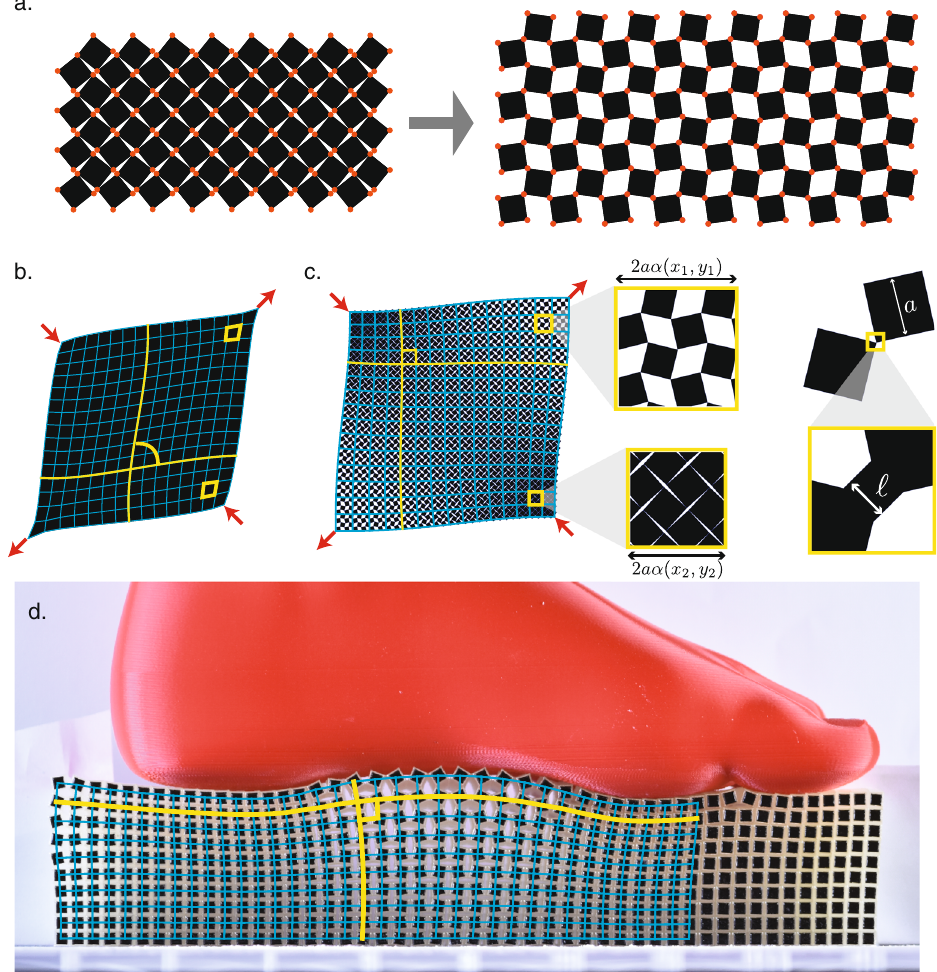
Fig. 1 Dilational mechanism and conformal deformations. a In the ideal rotating square mechanism, a structure of rigid squares (black) connected by frictionless hinges (red), may be dilated and contracted at zero energy cost when the squares are rotated opposite to their neighbors. b Applying fi xed deformations (red arrows) at the boundary of a conventional elastic material leads to a spatially varying strain fi eld that includes shear components that change the local angles between pieces of material, such as the initially perpendicular grid lines (blue, yellow). c In contrast, a pure dilational metamaterial designed around the RS mechanism, may accommodate the loading without shearing of the unit cells, so that even as grid lines rotate, the angles between them remain fi xed. This angle-preserving behavior arises due to a local version of the RS mechanism, in which square elastic chunks of side length a rotate about small, fl exible hinges of thickness ℓ to open and close pores according to α ( x , y ), the local linear dilation factor. d A fabricated sample of checkerboard material approximately preserves right angles (shown in yellow) under a generic nonlinear “ foot ” load, suggesting conformal deformation